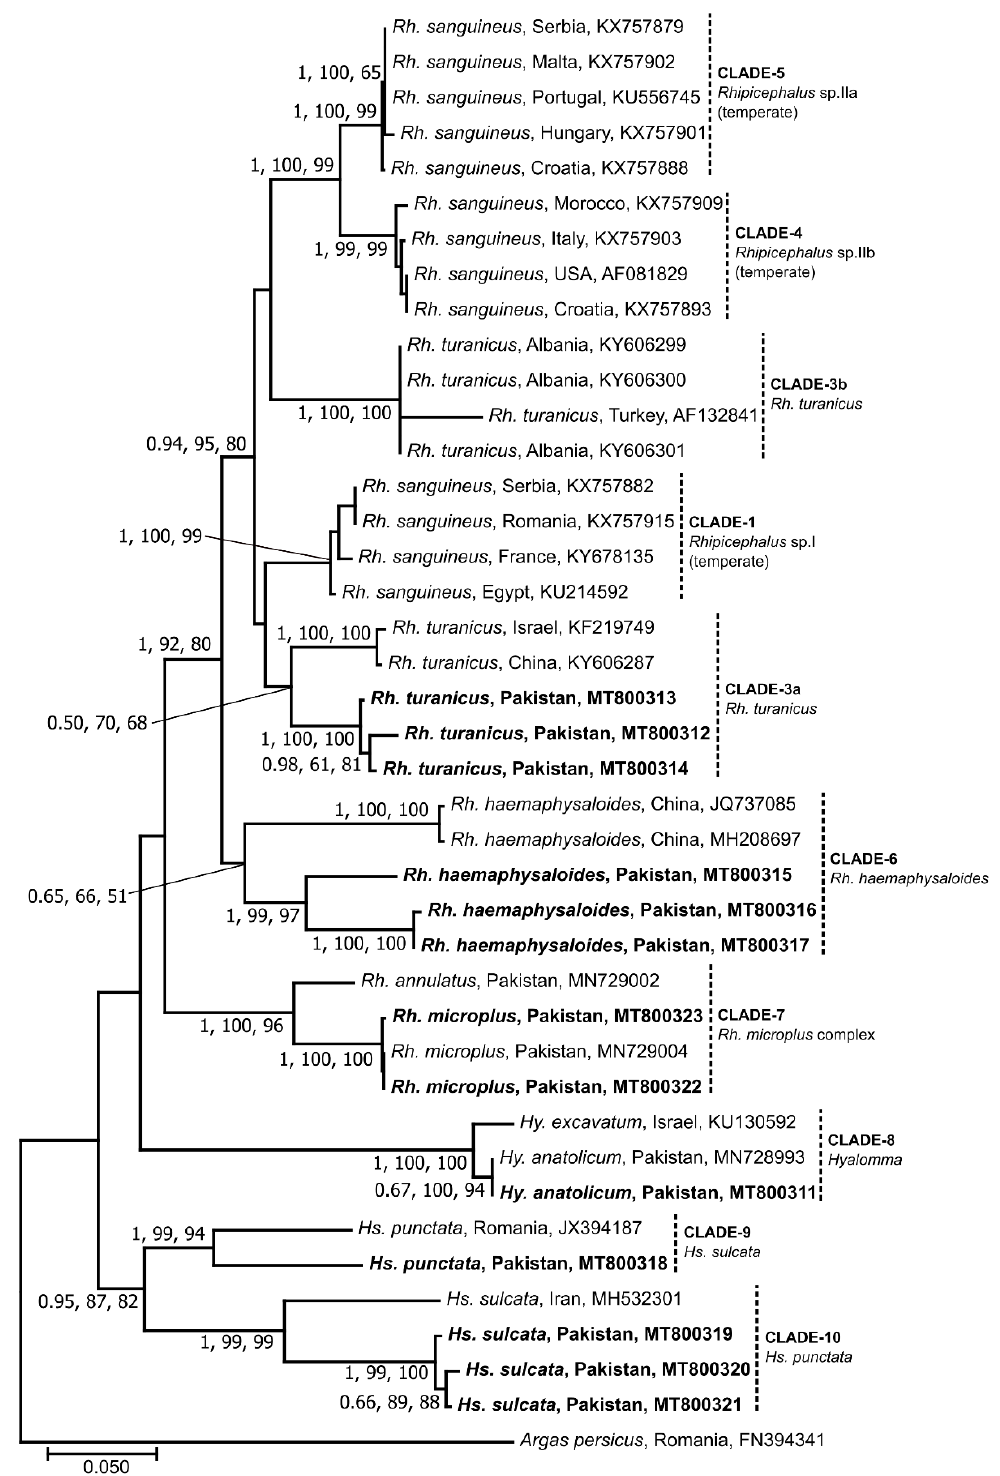
Figure 3. Phylogenetic relationships of partial cox 1 sequences of ticks collected from small ruminants in the FATA of Pakistan. Phylogenies were inferred using Neighbor Joining (NJ, this tree), Maximum Likelihood (ML) and Bayesian Inference (BI) methods. Sequences determined herein are shown in bold. The country of origin and GenBank accession numbers for each sequence are also provided. Nodal support values are presented as a posterior probability for BI (left) followed by bootstrap values for ML and NJ. The scale-bar indicates the number of inferred substitutions per site.